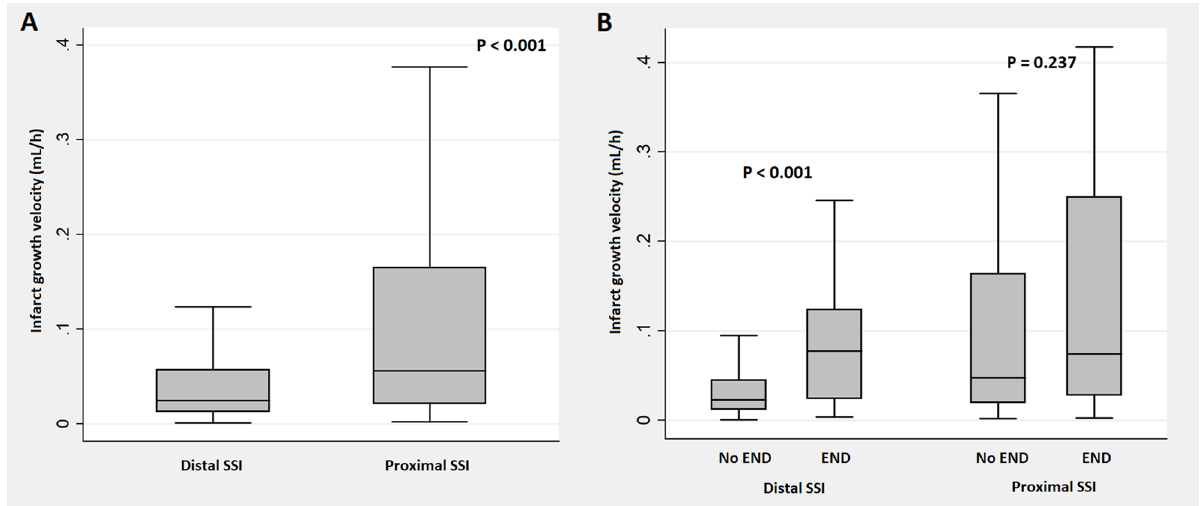
Figure 1. Comparison of infarct growth velocity in patients with distal and proximal single subcortical infarction according to the presence of early neurological deterioration. IGV infarct growth velocity, SSI single subcortical infarction, END early neurological deterioration. IGV values were higher in proximal SSI than in distal SSI ( P < 0.001). Significant differences in IGV values according to END were found only in distal SSI ( P < 0.001). No statistical significance was found in proximal SSI ( P = 0.237).